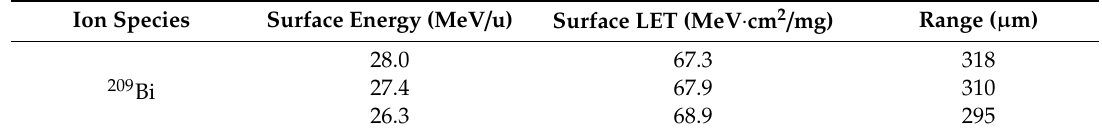
Table 3. The bismuth ion parameters using in the irradiation experiment.